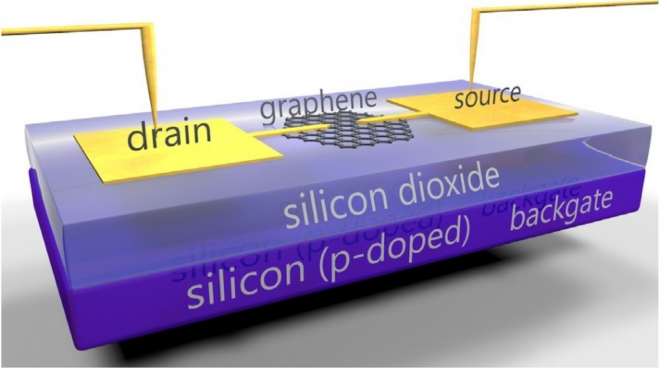
Figure 11. Schematic sketch of a GFET. (Reproduced with permission from ref